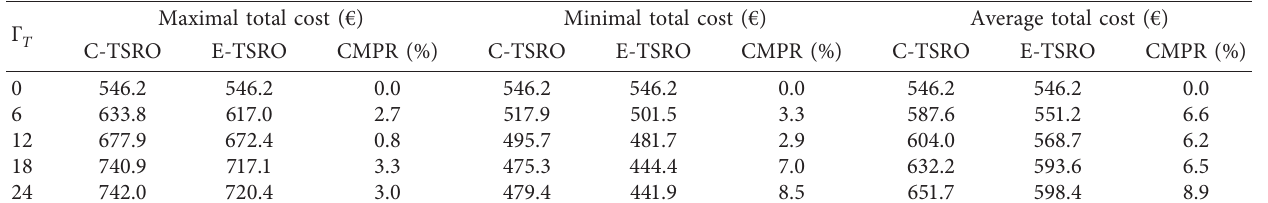
Table 11: Comparison of the average cost obtained using two models for various random values of uncertain parameters and different Γ values ( Γ S � 3 )